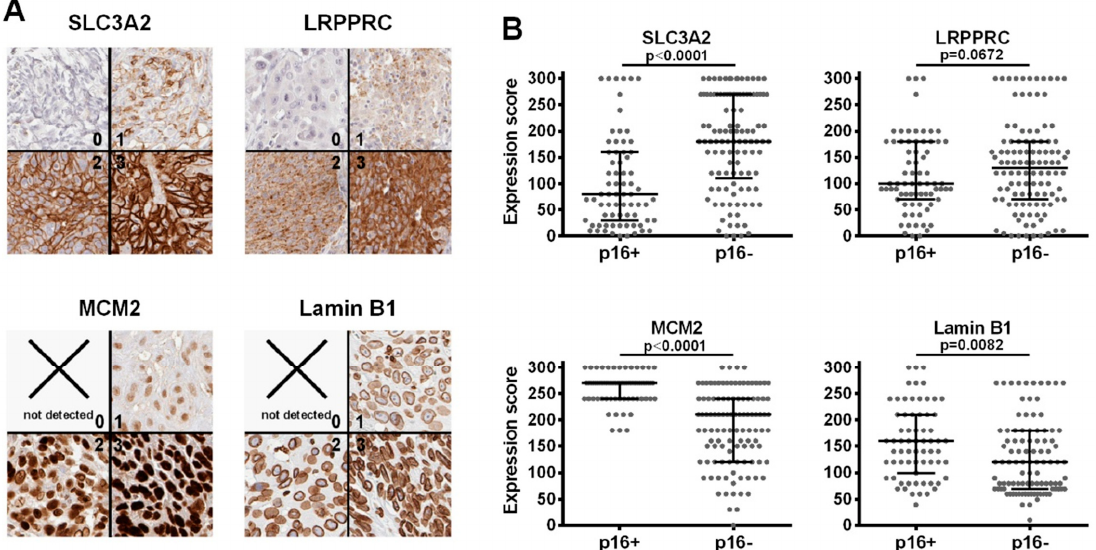
Figure 6. Validation of differential expression through IHC-analyses in an OPSCC tissue microarray. ( A ) Examples of staining intensities classified 0 (no), 1 (weak), 2 (moderate) and 3 (strong). ( B ) Semiquantitative expression scores (“maximum intensity” * “respective % of cells stained”)